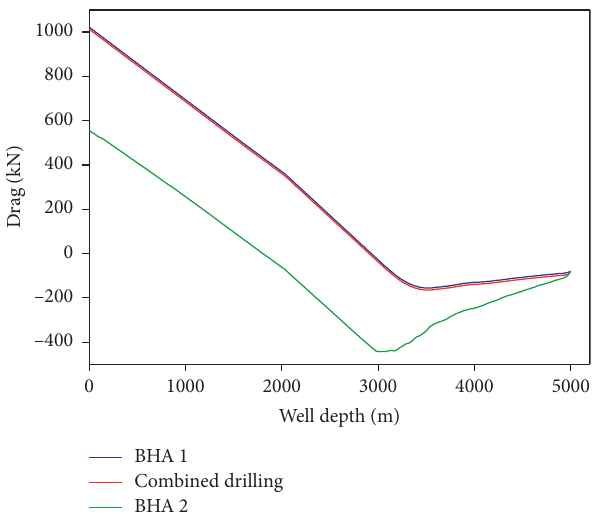
Figure 8: Drag force variation with well